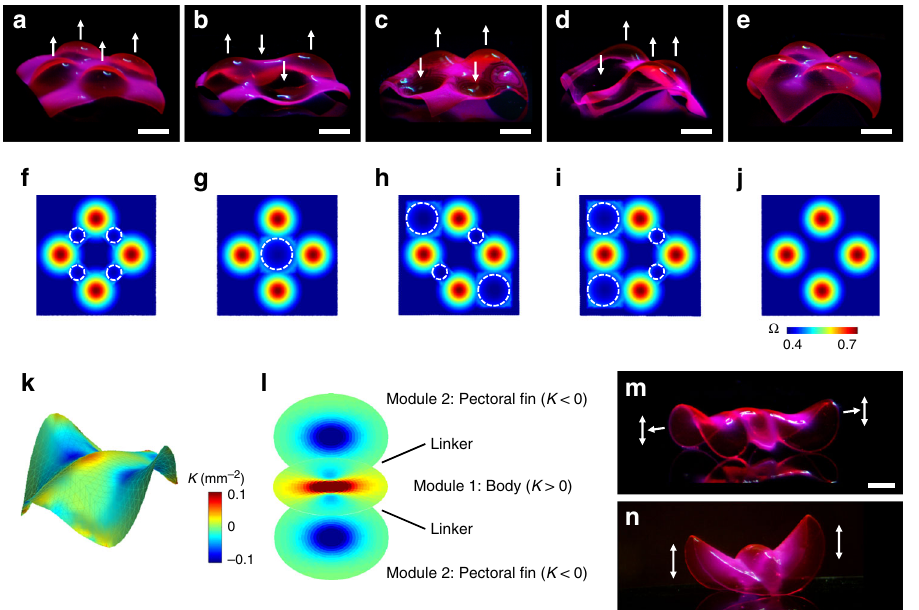
Fig. 4 Multimodular 3D structures. a – e Examples of multimodular 3D structures with 4 modules with ( a – d ) and without ( e ) directional control. The modules were programmed to deform in the directions indicated by the white arrows. f – j Strategies to control the orientation of the modules in the corresponding structures in a – e . The color maps illustrate Ω used to create the structures. The small and large circles with white dashed lines indicate the parallel and perpendicular transitional components, respectively. k Reconstructed 3D image of a stingray model with K . l Modular design of a stingray- inspired 3D structure in m . The modules for the body and the pectoral fi ns were designed based on the K map in k and Supplementary Figure 13. m , n Stingray-inspired 3D structures with oscillatory fl apping motions. The white arrows indicate the direction of the motions. Scale bars, 4 mm in a – e ; 2 mm in m ; 4 mm in (indicated by the small and large circles with white dashed lines in Fig. 4f – i, respectively) led to the multimodular structures with